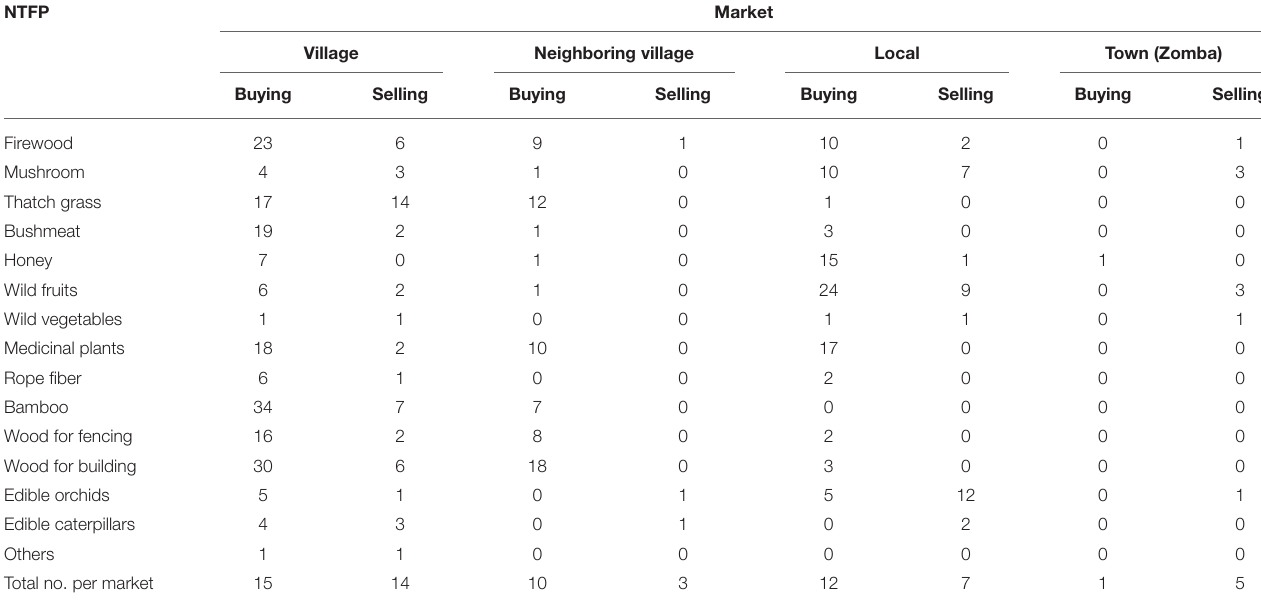
TABLE 3 | The proportion (%) of households ( n = 268) buying and selling at different markets.